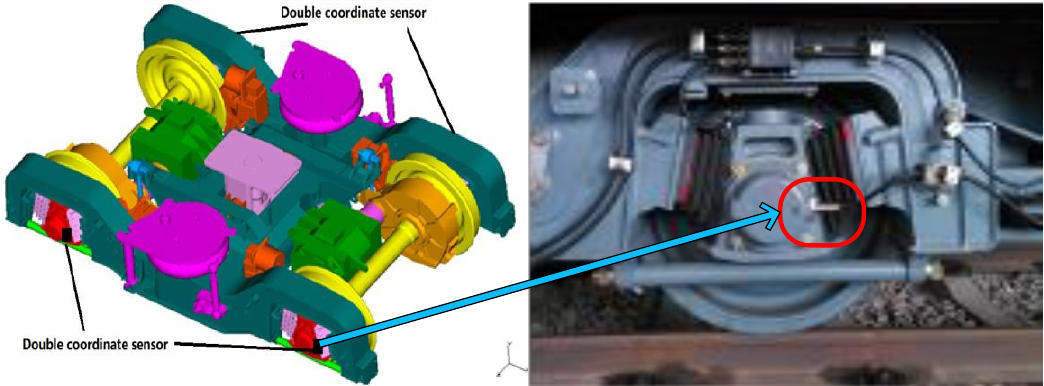
Figure 10. Locations of the accelerometers.